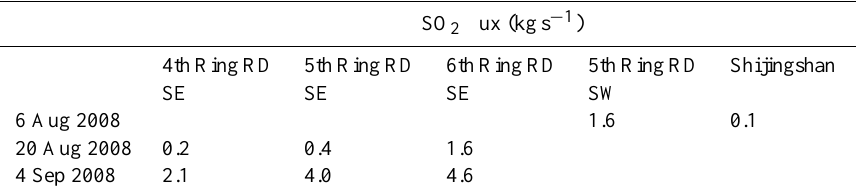
Fig. 6. Boxplots of the SO 2 concentrations on the ring roads in southeast of Beijing during the measurement periods. The small block indicates the mean value and the upper, middle and bottom layers of the box show the 75, 50, 25th percentiles of the dataset. The bars are determined by the 5 and 95th percentiles of the dataset and ‘ × ‘ show the maximum and minimum values respectively. Table 3. SO 2 import fluxes and local emission derived from mobile laboratory in different routes surrounding